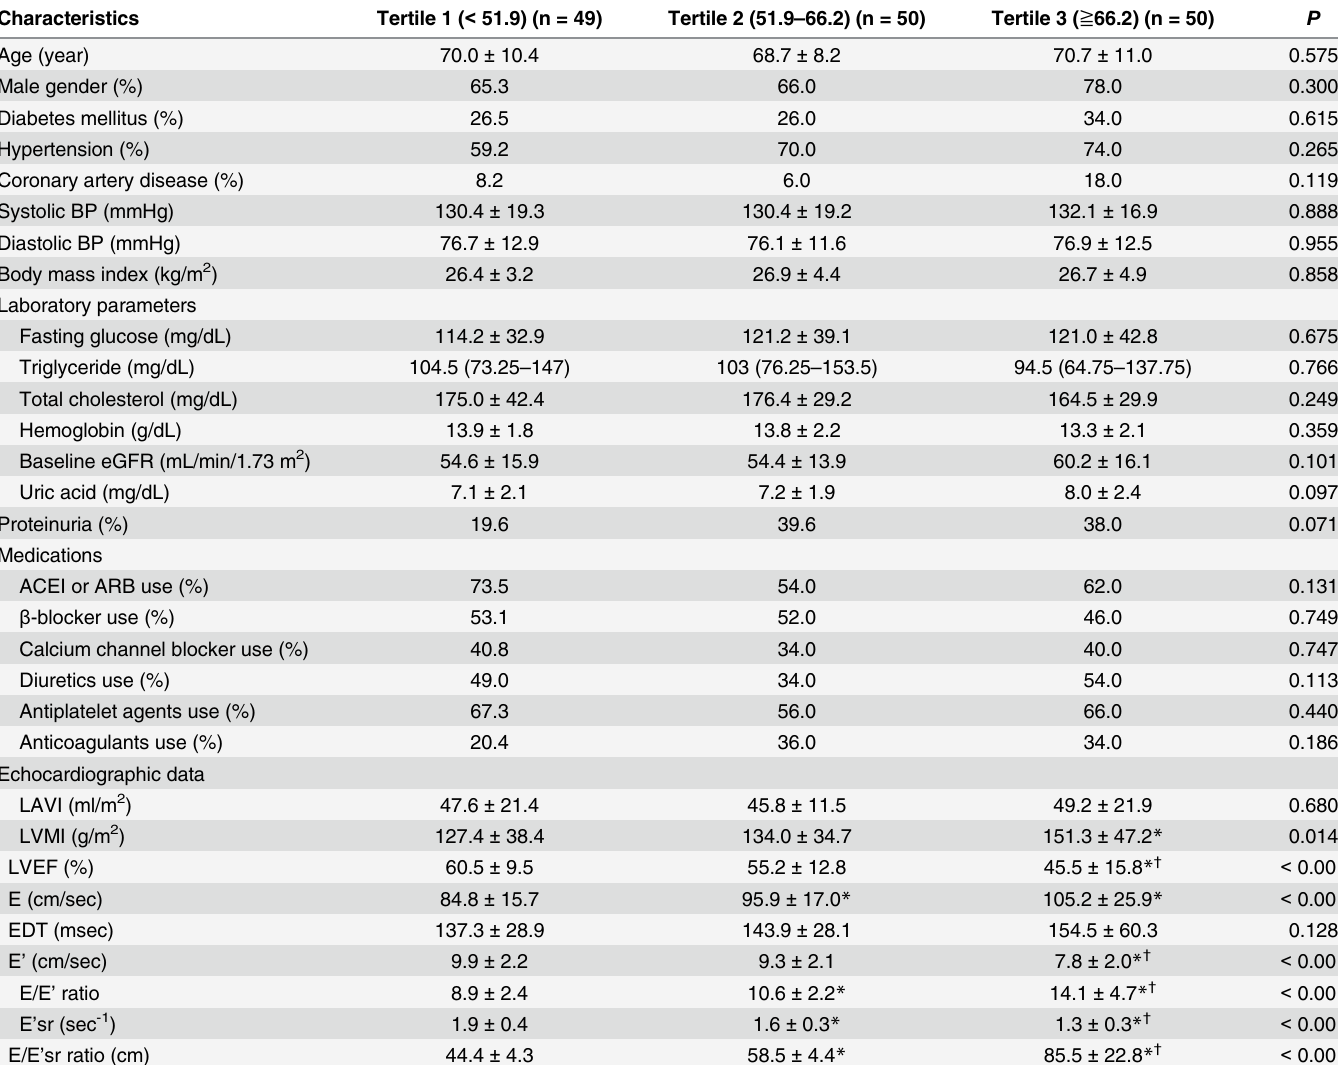
Table 2. Comparison of clinical and echocardiographic characteristics among patients according to teriles of E/E ’ sr ratio.